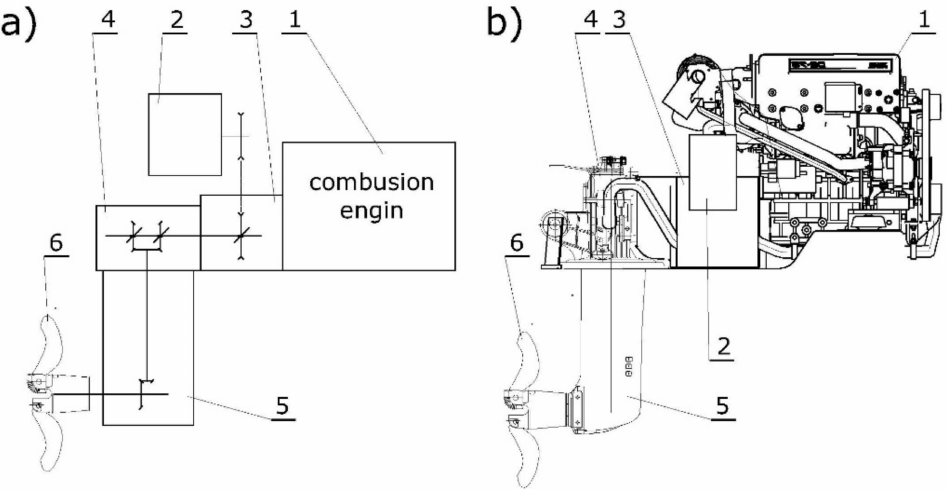
Figure 3. Designed and built parallel hybrid drive system; ( a ) schematic, ( b ) assembly drawing; 5—bottom reduction gear,